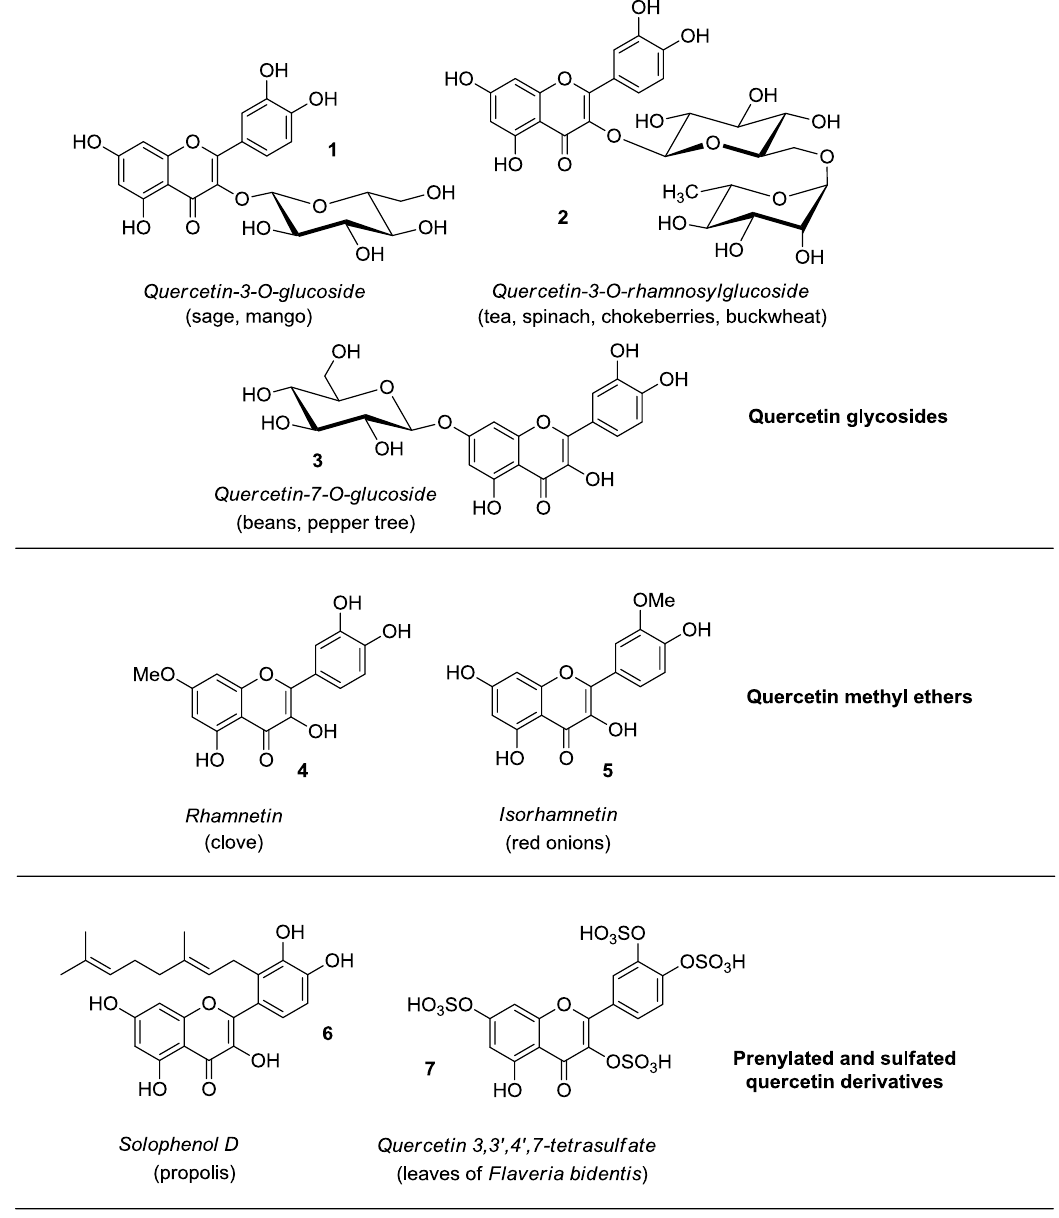
Figure 2. Structures of quercetin derivatives 1 – 7 along with their occurrence in food and plants.